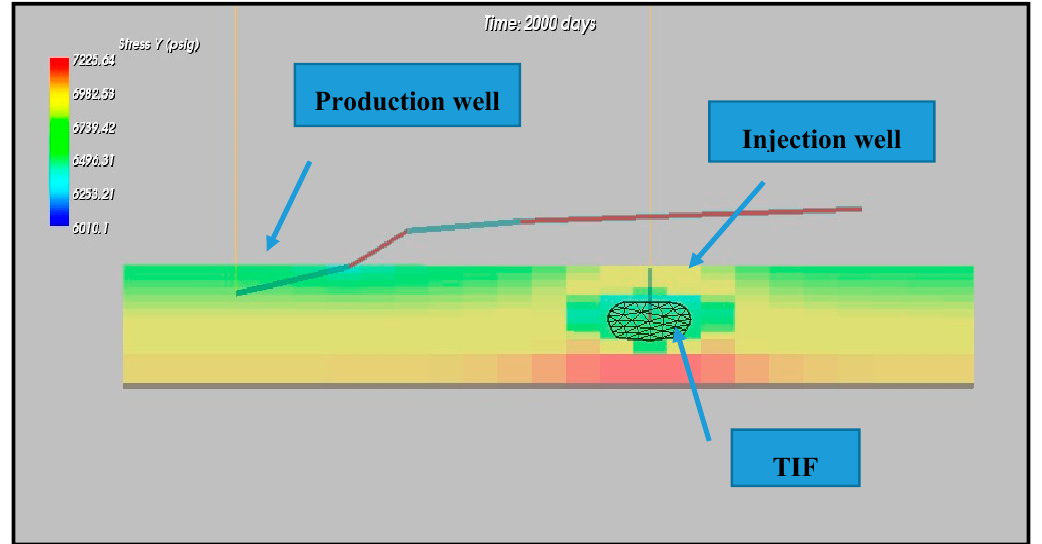
Figure 2. Stress evolution around a vertical water injector [4].